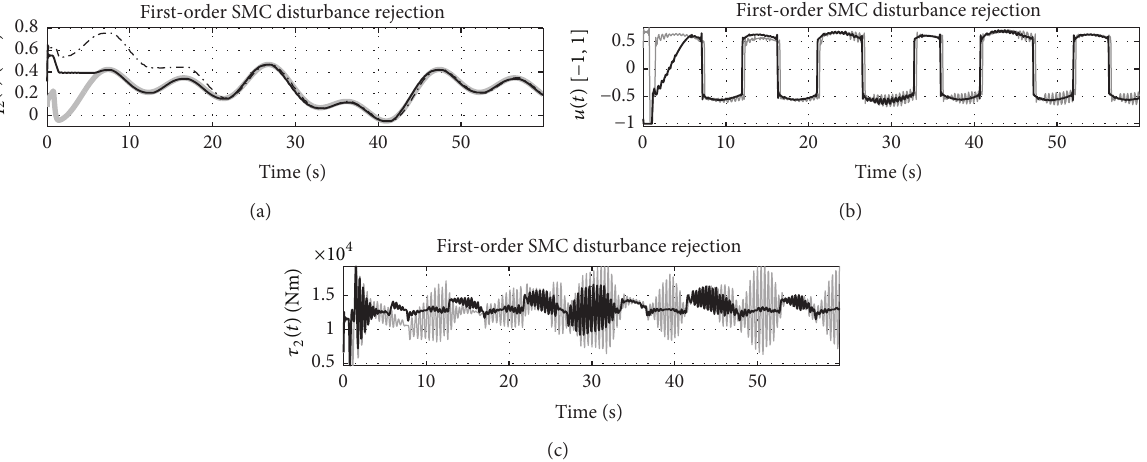
Figure 12: Experimental results of disturbance rejection with a first-order SMC. (a) Angular link displacement in radians . The bold signal shows the results applying the chattering reduction method (47), the striped signal shows results with the original formula (36), and the gray signal is the reference trajectory. (b) Control input . The bold signal shows the results applying the chattering reduction method (47) and the gray signal shows results with the original formula (36). (c) Computed torque from pressure measurements . The bold signal shows the results applying the chattering reduction method (47) and the gray signal shows results with the original formula